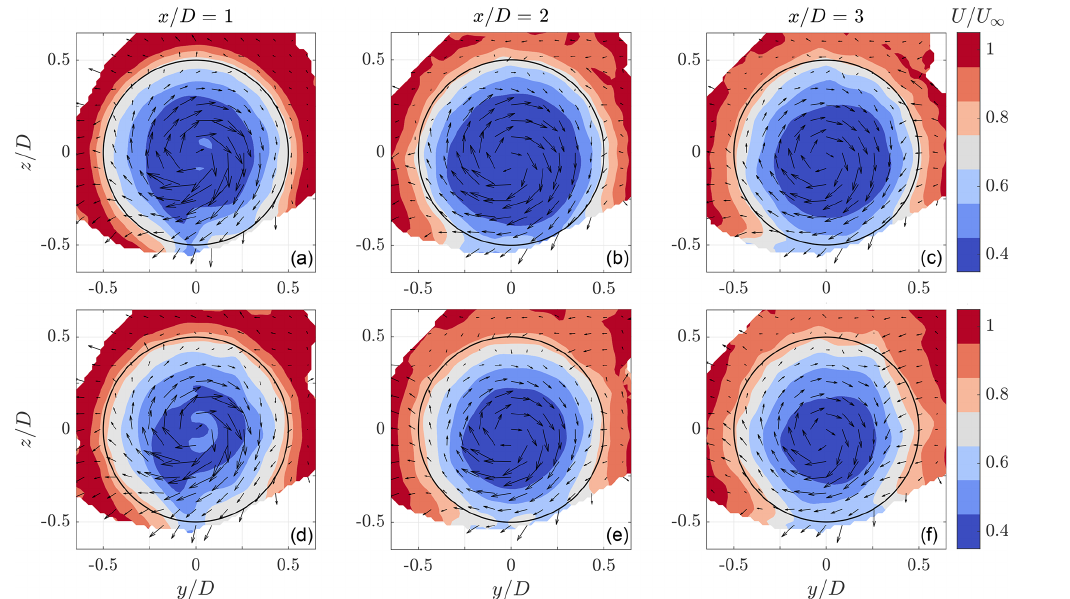
Figure 6. Cross-sections of the wake at distances ranging from 1 to 3 diameters downstream of a turbine operating with baseline control (a– c) and DIC with St = 0 . 24 (d–f) . The contours show the average normalized streamwise velocity component, while the arrows indicate the cross-stream velocity components. The black circles indicate the relative location of the rotor disk of the model wind turbine.